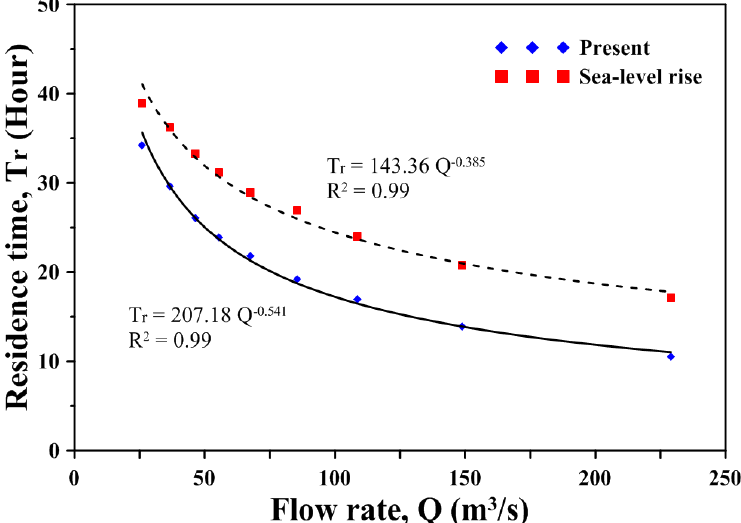
Figure 13. Regression between residence time and freshwater input for the present condition and the sea level rise